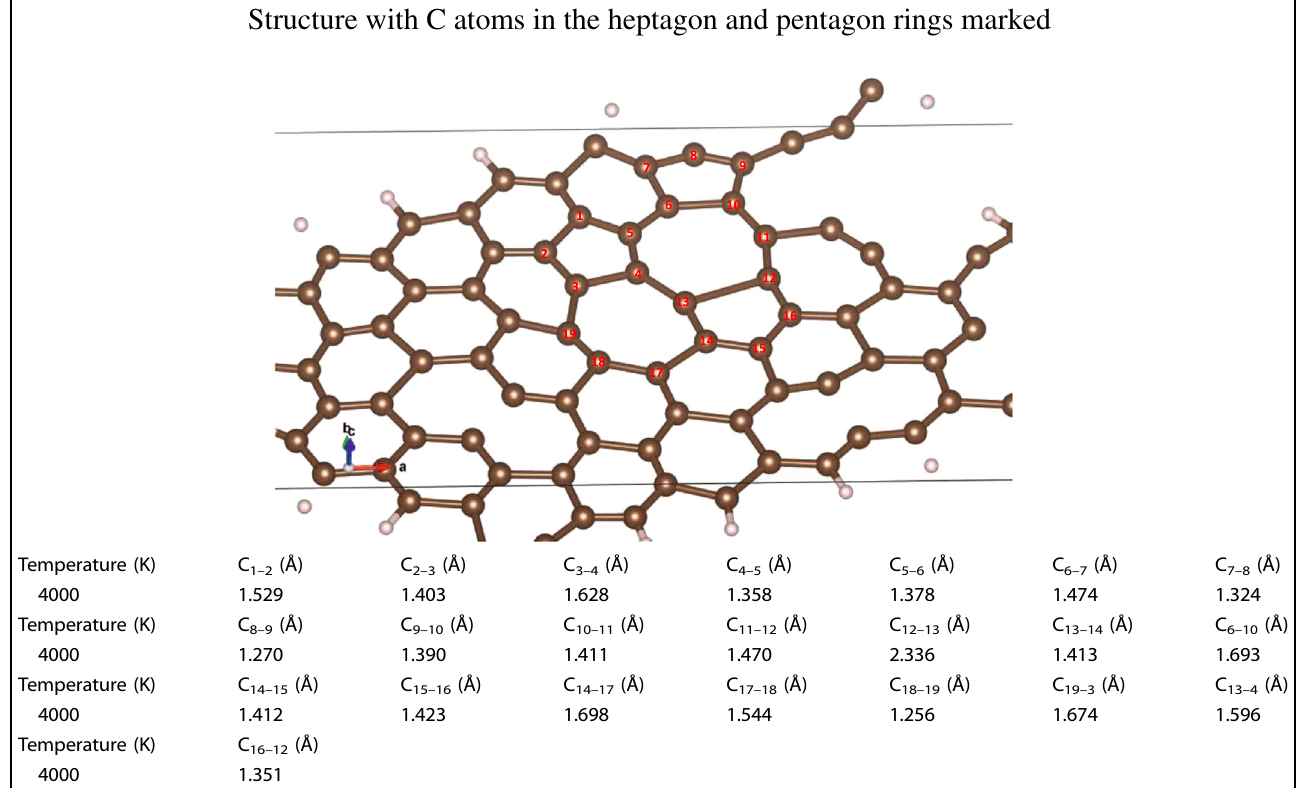
Table 2. Distances between C atoms in 5-7-7-5 defect regions as formed at 4000 K temperature after 2 ps.